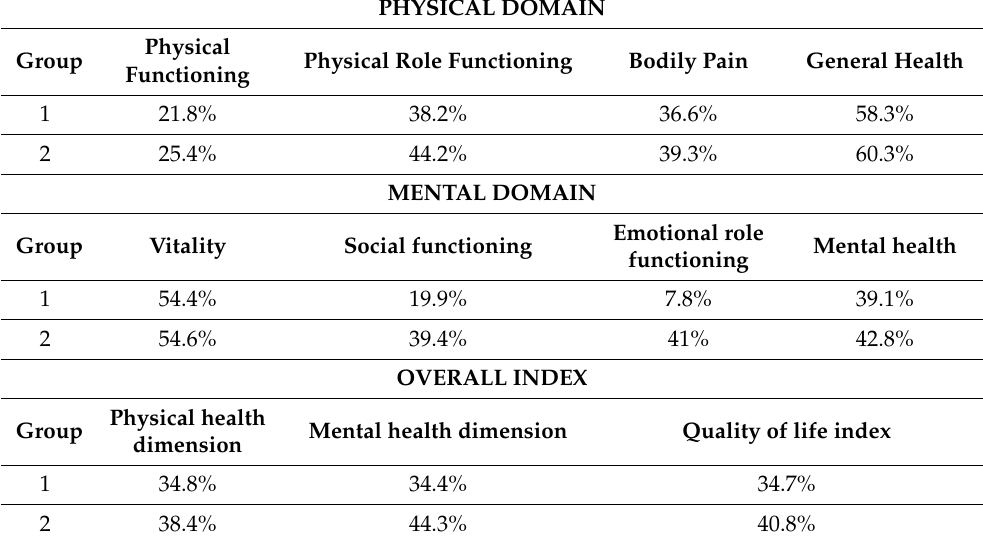
Table 11. Quality of life